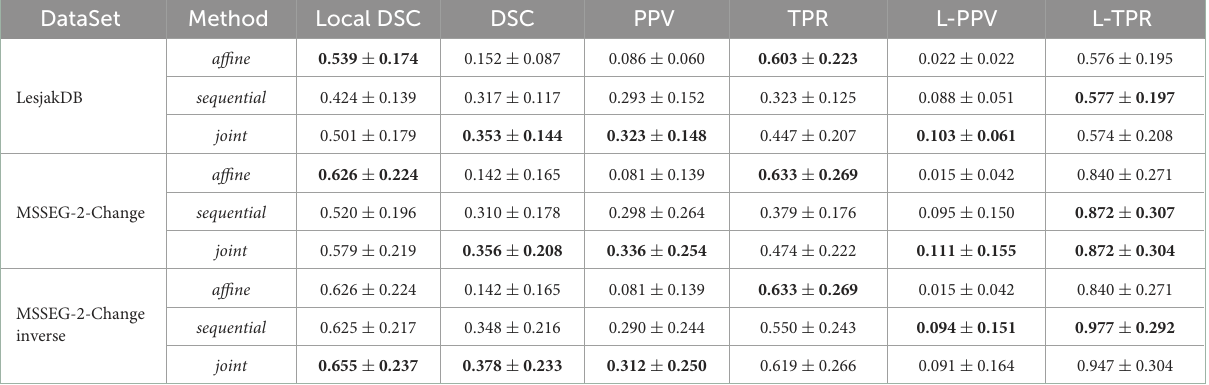
TABLE 3 Results computed on LesjakDB and MSSEG-2-Change